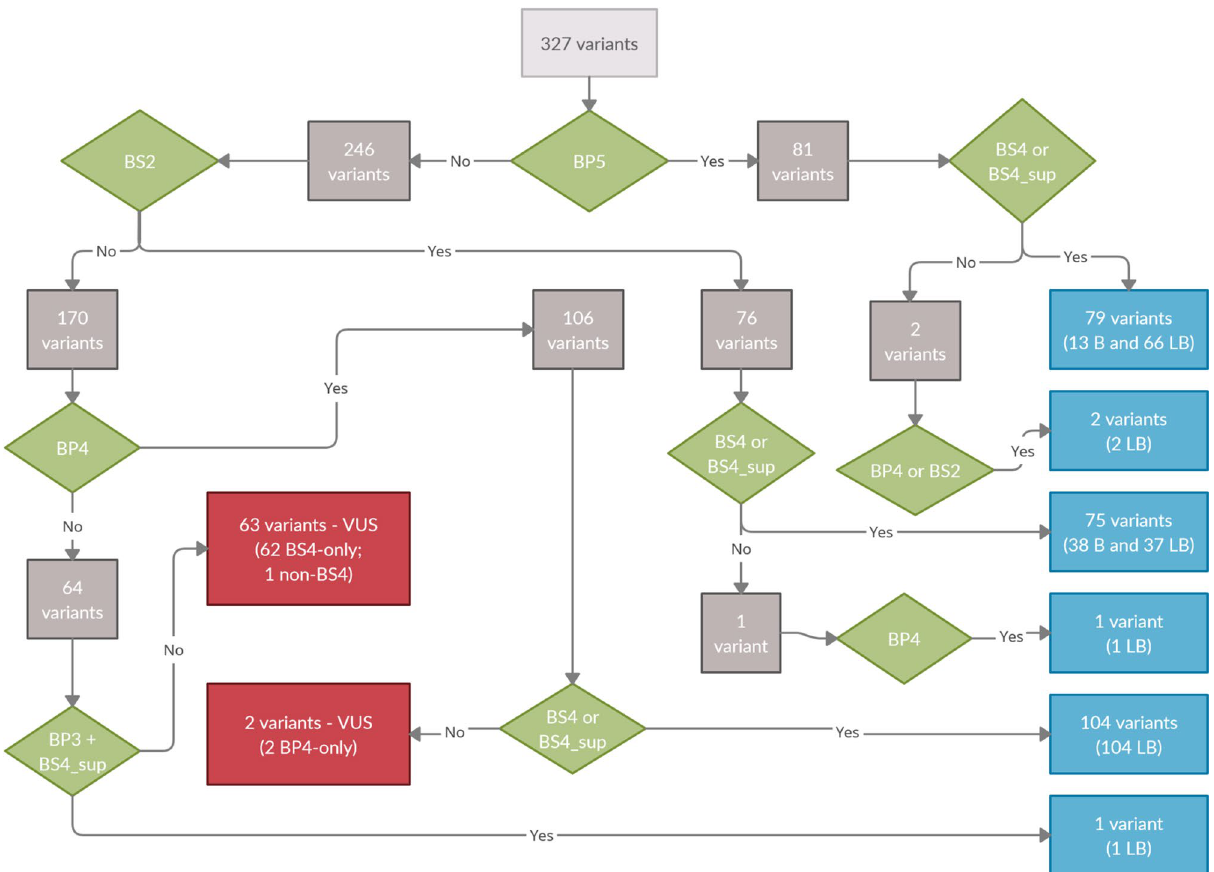
Figure 1. Workflow of classification of all 327 variants. The figure shows the workflow with the key benign criteria used to classify all 327 unique rare variants in the autosomal dominant model of inheritance. Green diamonds represent the main benign criteria used for variant classification; grey squares represent the number of variants flowing in the decision tree; blue squares congregate all variants classified as benign or likely benign and red squares represent the variants that did not meet minimum requirements for classification as benign or likely benign and kept a final classification of variants of unknown significance (VUS). Note that the 327 variants are initially divided into two groups: 81 variants received the BP5 (supporting) criterion because these variants occurred in patients with a clear molecular alternate cause of disease; 79 out of these 81 variants were inherited from predictively asymptomatic parents, received either BS4 or BS4_supporting criterion and were classified as benign (13 variants) or likely benign (66 variants); two out of these 79 were not inherited (one variant was not found in both parents and for the other one paternal sample was not available): one of them received the BP4 criterion and the other received both BS2 and BP4 criteria and both were classified as likely benign. The remaining 246 variants did not receive BP5 and followed the classification flow. Among the remaining 246 variants, 76 received BS2 criterion because they were found in at least five controls from gnomAD database: 75 were inherited from parents and received an additional BS4 or BS4_supporting and were classified as benign (38 variants) or likely benign (37 variants); one variant was not inherited (not found in parental samples), but as it received the BP4 criterion it was classified as likely benign. Among the remaining 170 that did not receive either BP5 and BS2 criteria, 106 were predicted as having benign effect by REVEL and received BP4 criterion: 104 variants were inherited from parents, received additional BS4 or BS4_supporting criteria and were all classified as likely benign; two variants were not found in parental samples and were classified as VUS since they received only BP4 criterion. Finally, 64 variants did not receive BP5, BS2 nor BP4 criteria: one of them was an inframe indel in non-functional domain (BP3), inherited from the mother (BS4_supporting) and was classified as likely benign; 63 variants did not meet minimum requirements for reclassification (62 were inherited and received only the BS4 or BS4_suporting criteria and one variant was not inherited) and were considered Figure 1 resumes the key workflow steps of the variant classification. A total of 81 variants occurred in patients with a clear molecular alternate cause of disease and received the BP5 (supporting) criterion. All these 81 variants were classified as benign (n = 13) or likely benign (n = 66) because they also received, at least, another benign criterion either because were inherited from predictively asymptomatic parents (n = 79) receiving BS4 or BS4_supporting criterion or REVEL score suggested no impact (n = 2). Note that two variants were not inher- ited—non-inherited variants will be discussed below. In this branch of cases shown in Fig. 1, the combination of BP5 and BS4/BS4_supporting was key for non-pathogenicity assumption. Figure 2 demonstrates that this